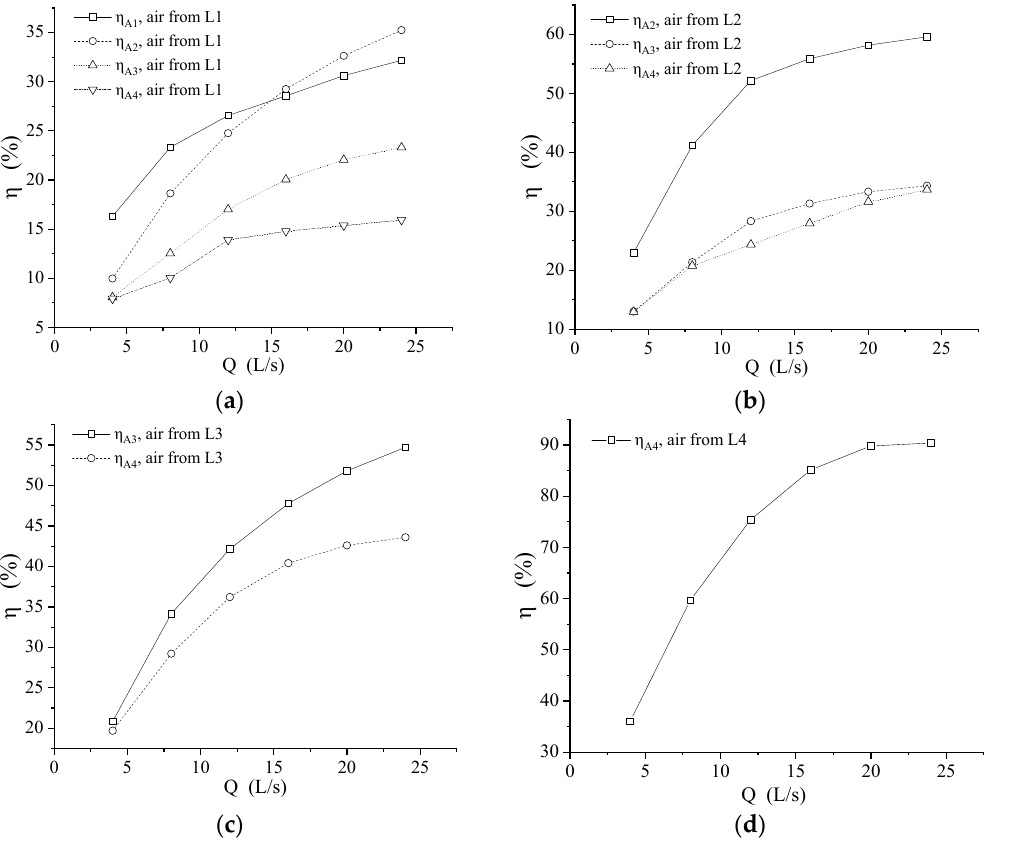
Figure 21. Drag reduction in the underwater areas with di ff erent air injection locations: ( a ) Air injected from L1; ( b ) Air injected from L2; ( c ) Air injected from L3; ( d ) Air injected from L4.